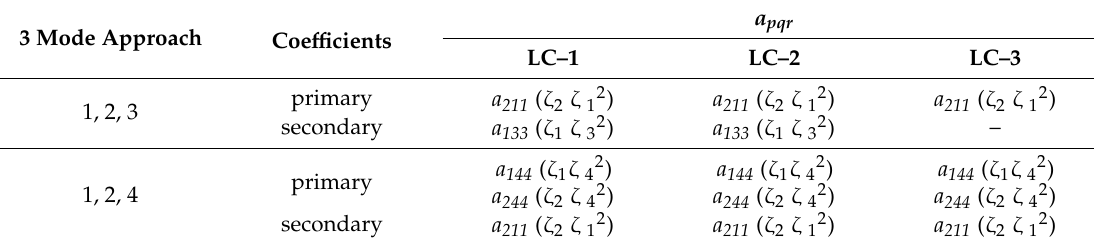
Table 10. Primary and secondary coe ffi cients a pqr for LC–1, LC–2 and